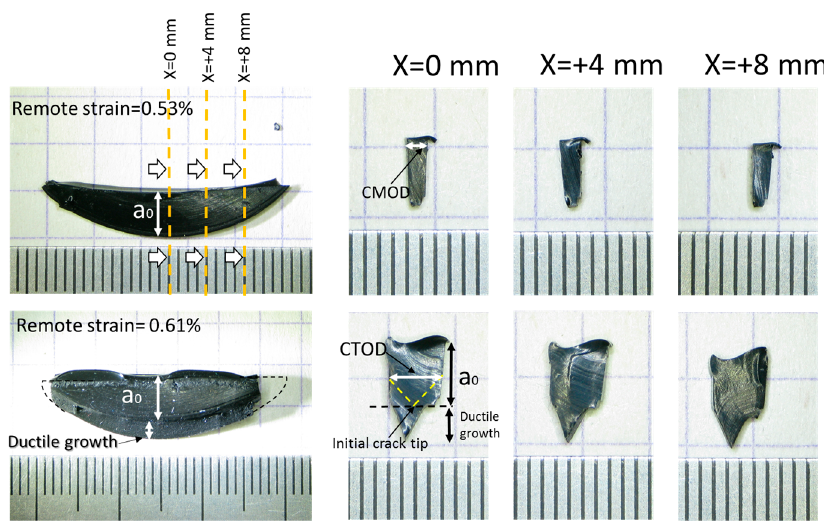
Figure 5. Replica casting cross sections at various distances from crack center.